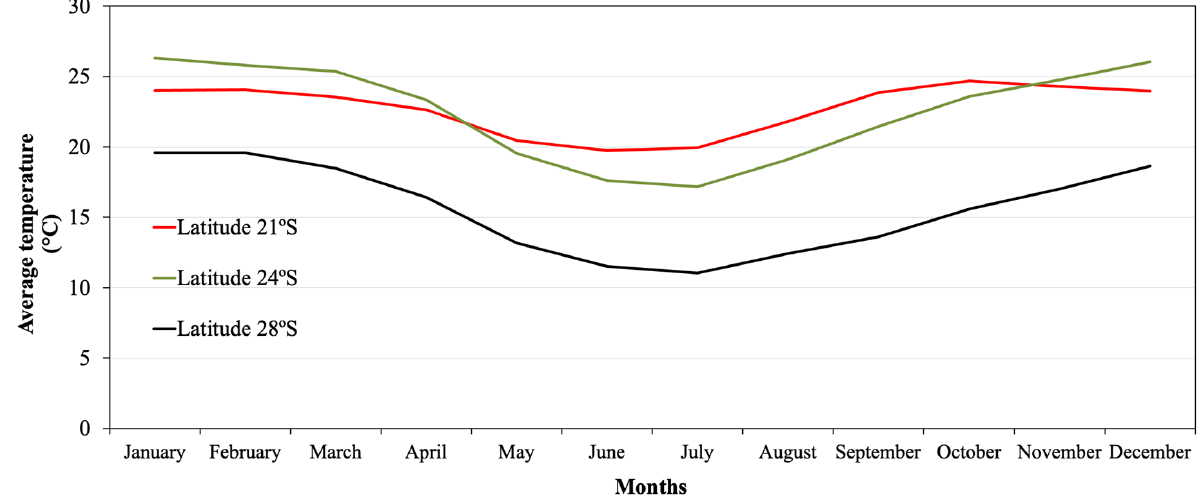
Figure 4. Average temperature (°C) throughout the year in three locations in Brazil: Lages, Santa Catarina state (latitude 28° S), Palotina, Parana state (24° S), and Ribeirao Preto, Sao Paulo state (21° S). A 25 km buffer was generated around each region to obtain monthly data from 1982 to 2021. However, there are some limitations to obtaining two production cycles in higher latitude regions regularly, especially because of low minimum air temperatures (<10 ◦ C) that frequently occur from early May to early September (Figure 5), not allowing enough time for hops to complete a second production cycle before mid-April. In lower latitudes, such as in Ribeir ã o Preto (21 ◦ S), high average temperatures between July and August are characteristic of a tropical climate, but in this period, the precipitation is very low, requiring supplementary irrigation most of the year.